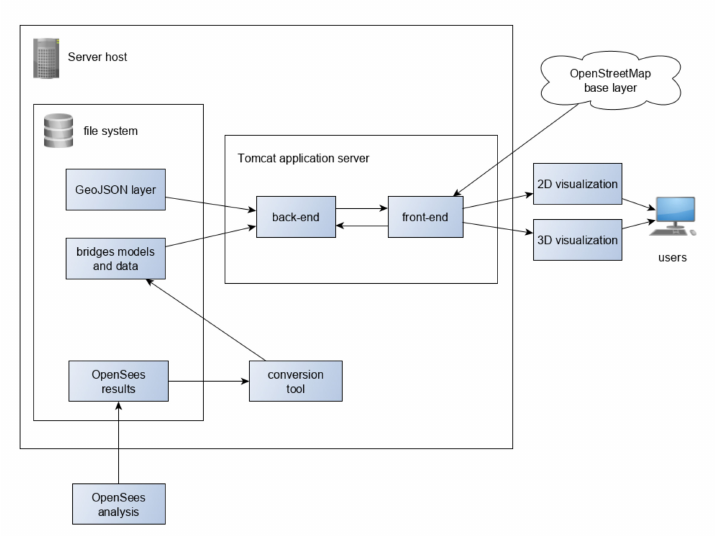
Figure 15. System